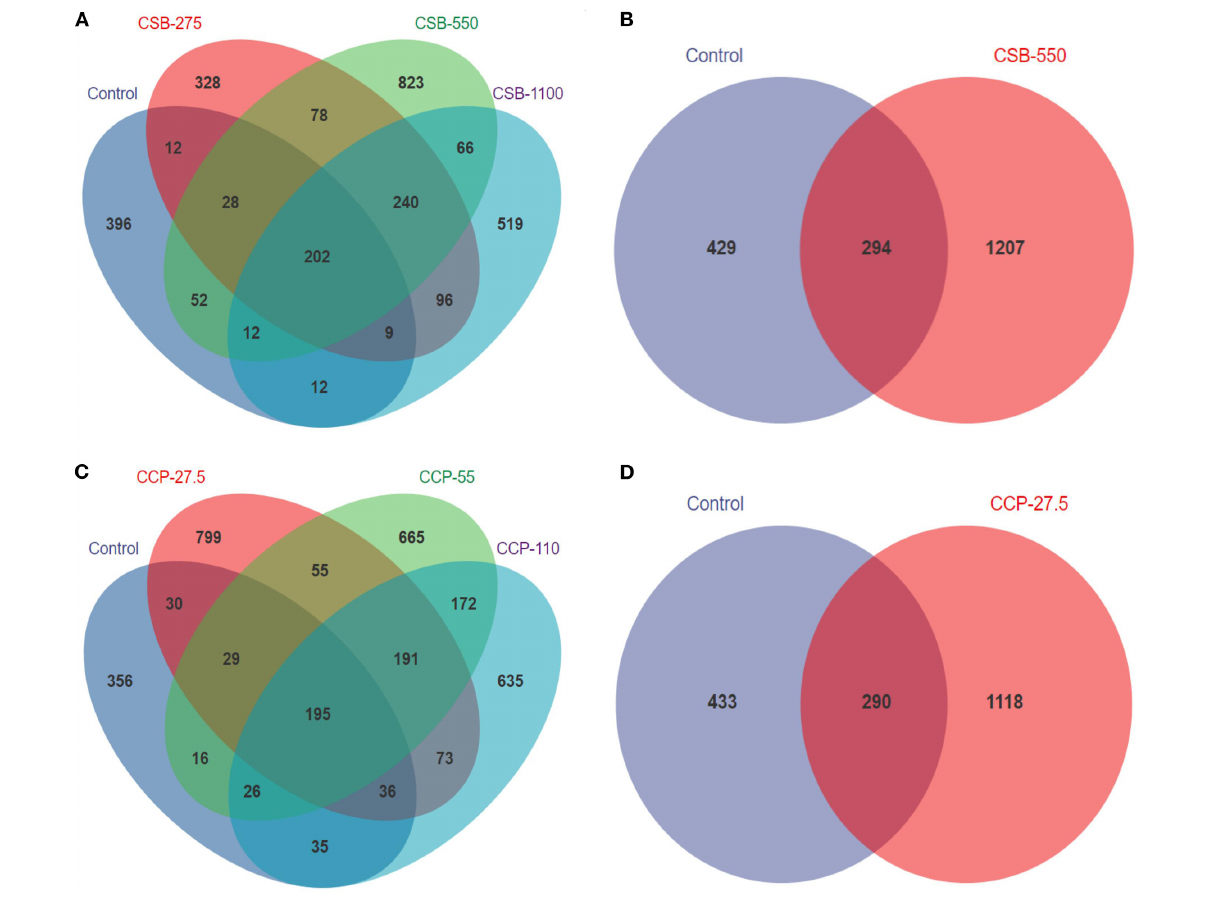
Frontiers in Veterinary Science |